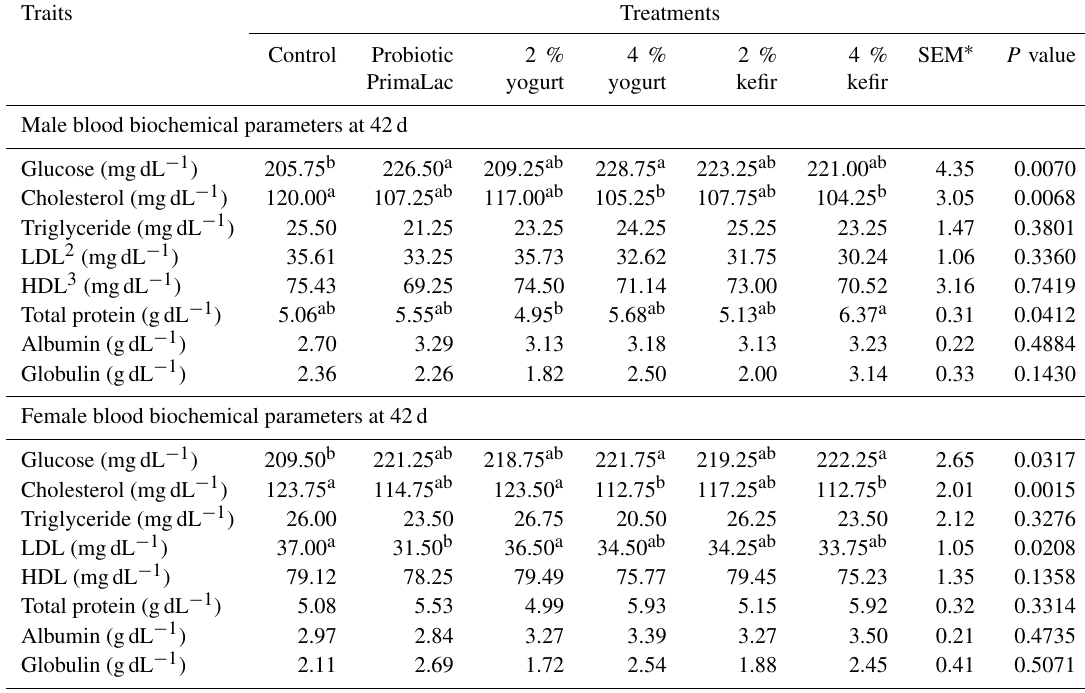
Table 7. The effects of using kefir, yogurt, and probiotic on hematological parameters in male and female broiler chickens at 42d. Traits Treatments Control Probiotic 2 % SEM ∗ PrimaLac